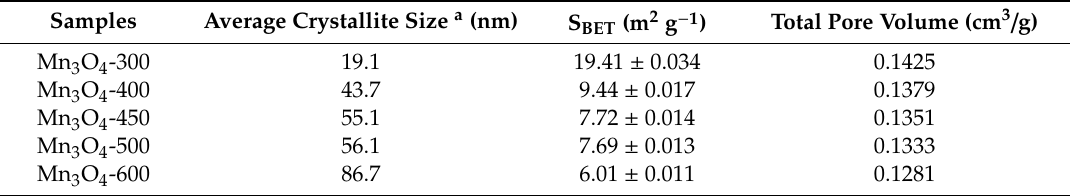
Table 1. Structure of properties of Mn 3 O 4 derived from Mn–BTC under di ff erent calcination temperatures.